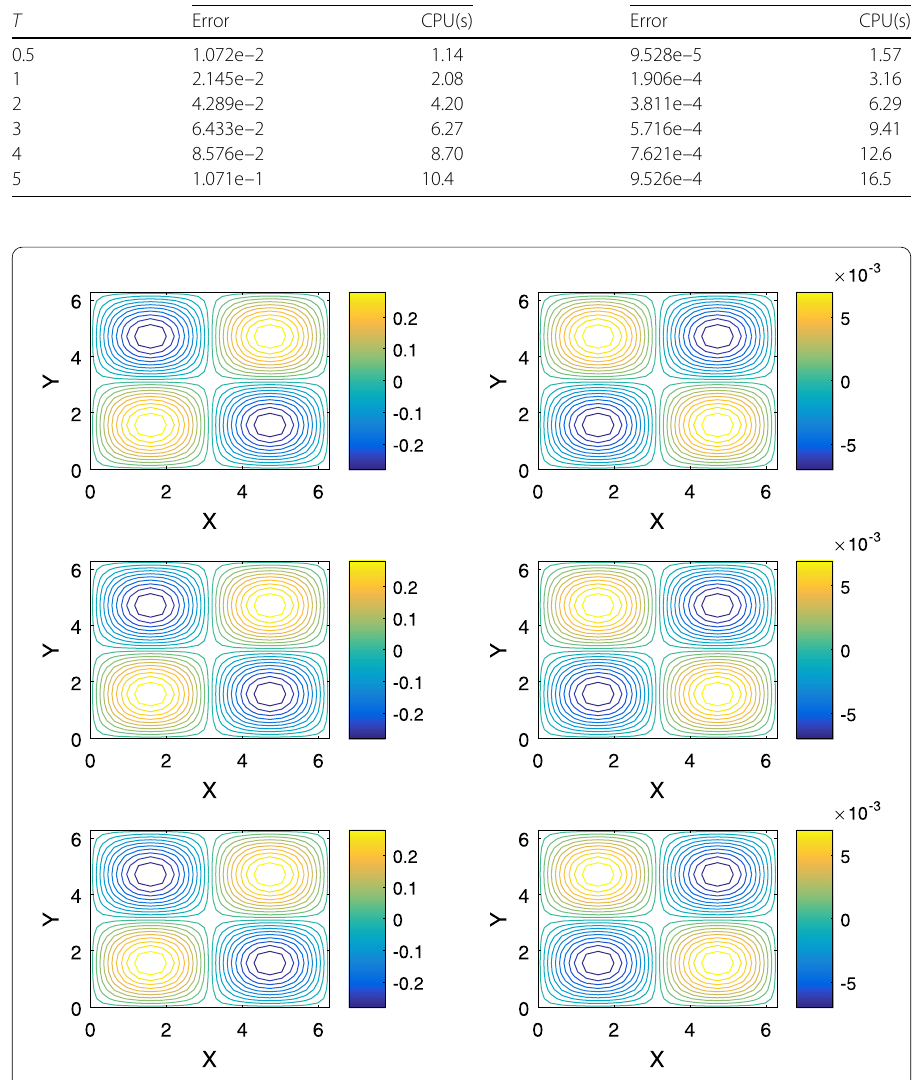
Figure 4 The contour plot of exact solution and numerical solutions to Example 2 at T = 0.01, z = 0.5 with N = 100 and M = 20. (Left panel for real part and right panel for imaginary part corresponding to the exact solution, solutions by the D-G ADI splitting scheme, and solutions by the new HOC-ADI splitting scheme,